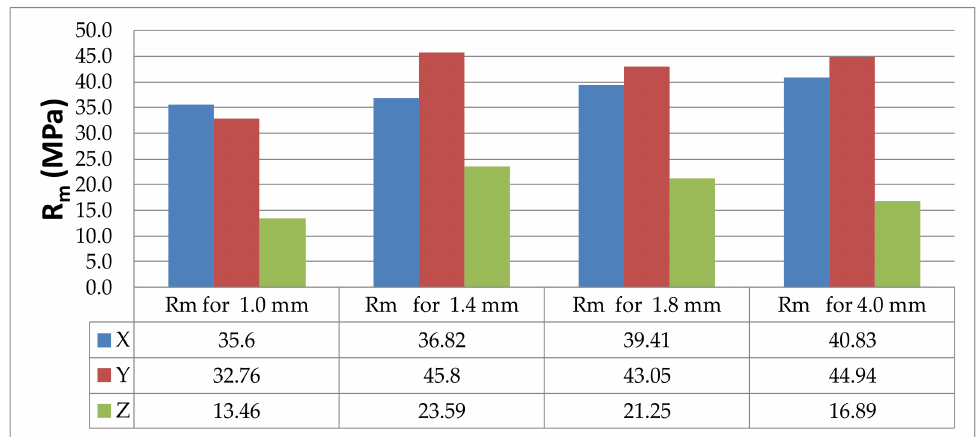
Figure 24. Ultimate tensile strength R m for the PLA specimens differing in thickness and print direction, where X, Y and Z are printing